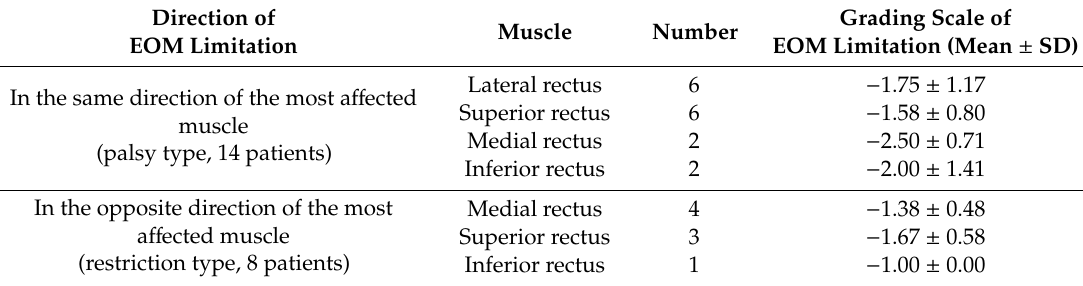
Table 2. Analysis of extraocular muscle (EOM) limitation by involved muscles. Direction